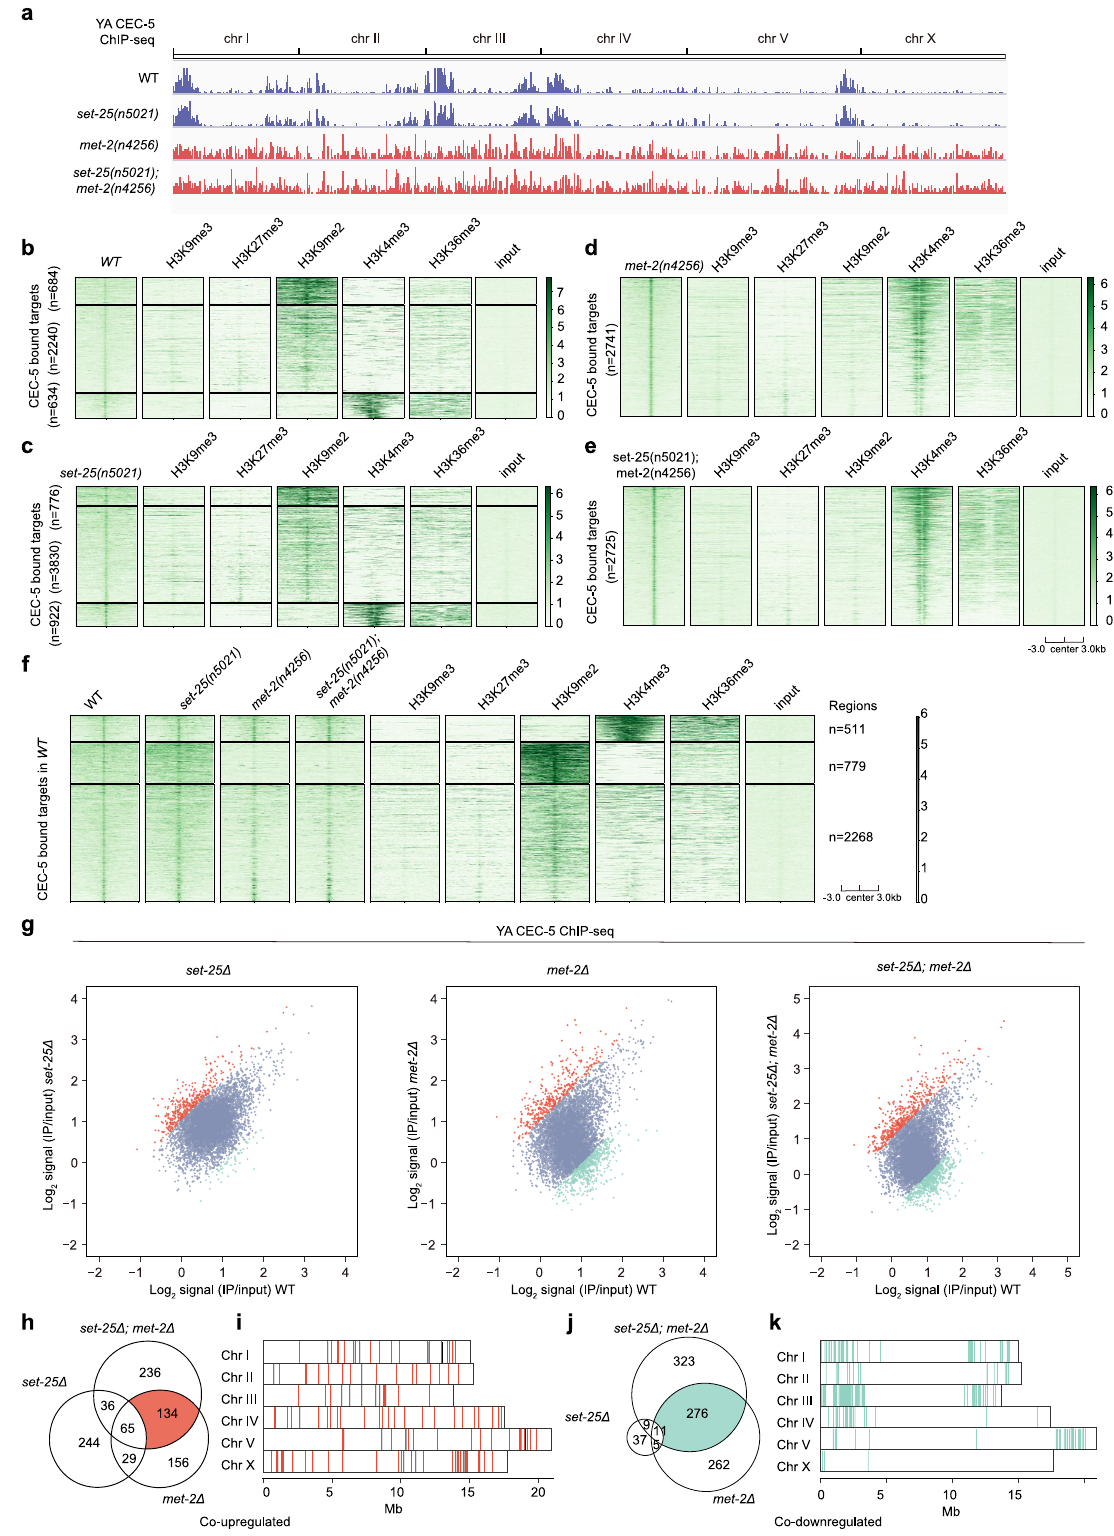
Fig.5|TheassociationofCEC-5withchromatindependsonH3K9me1/2.a ChIP- seq peak distribution of CEC-5 in the indicated adult animals. b – e Heatmaps comparing heterochromatin histone modi fi cations (H3K9me2, H3K9me3, H3K27me3) and euchromatin histone modi fi cations (H3K4me3, H3K36me3) with CEC-5 in the indicated animals. f Heatmap comparing CEC-5( WT ), CEC-5( set-25 ), CEC-5( met-2 ) and CEC-5( set-25 ; met-2 ) ChIP-seq signals with heterochromatin his- tone modi fi cations (H3K9me2, H3K9me3, H3K27me3) and euchromatin histone